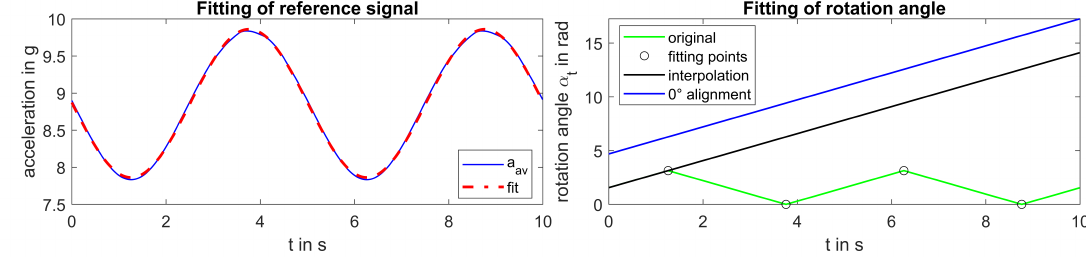
Figure 6. Left : fitting a reference signal to measured av -acceleration for angle estimation. Right : estimation of rotation angle α t at constant angular speed.